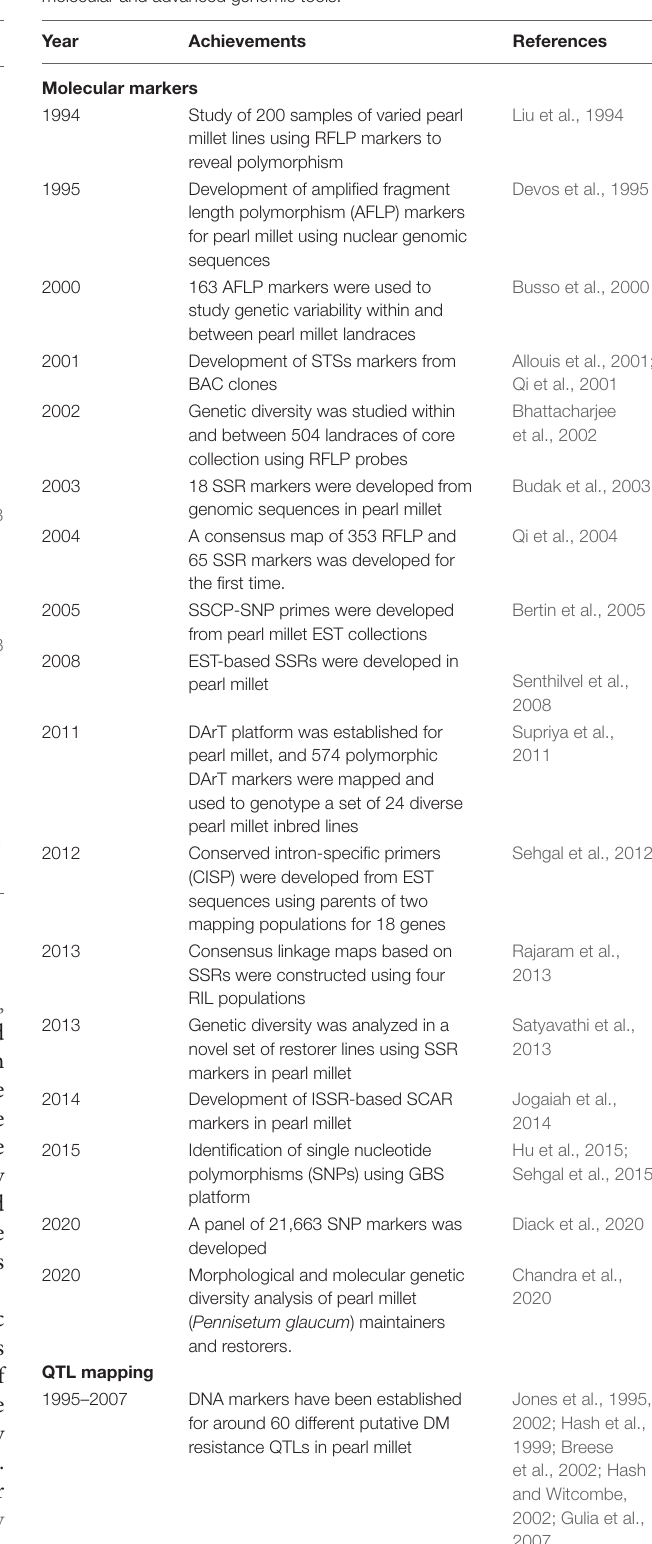
TABLE 2 | Achievements and milestones in pearl millet improvement through molecular and advanced genomic